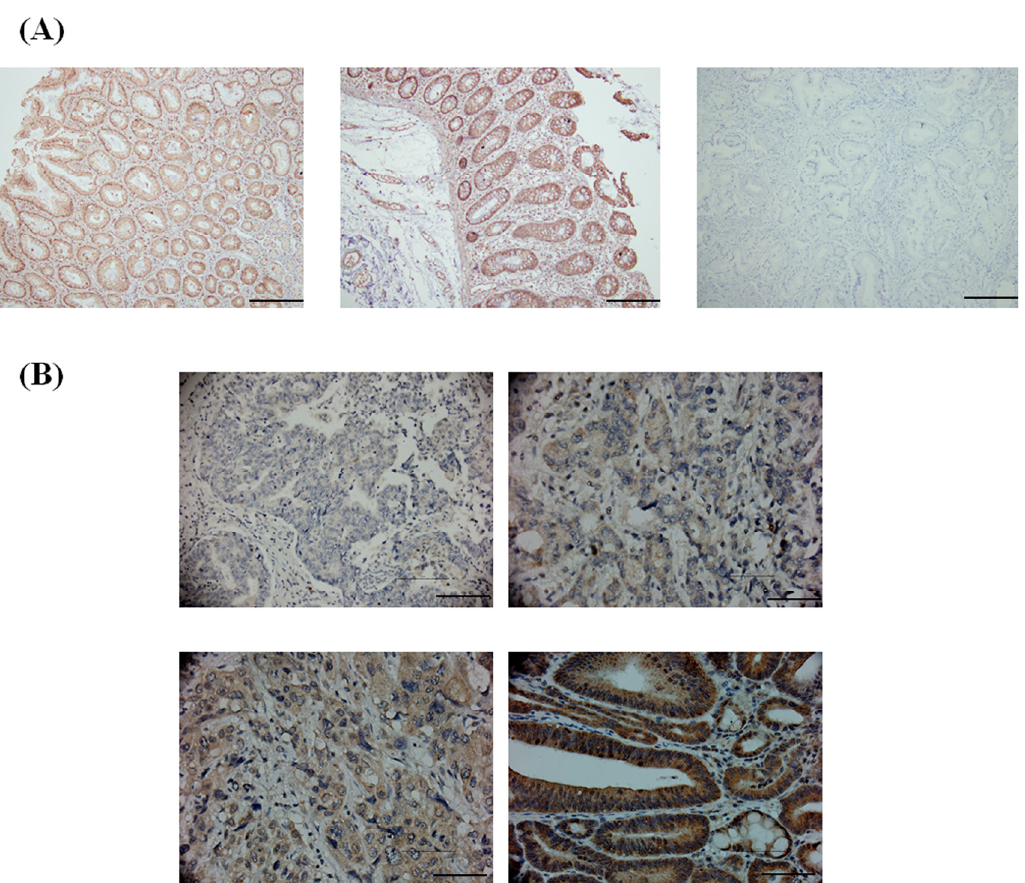
Figure 1. The expression patterns of KLF10 in gastric cancer. ( A ) Representative Immunohisto- chemistry (IHC) images of immunohistochemical staining of KLF10 gastric tissues. Left panel: IHC staining of normal gastric tissue. Middle panel: positive IHC staining region in normal gastric tissues. Right: IHC staining without KLF10 antibody in gastric tissues as negative control. All images magnification × 100. Scale bar: 5 µ M. ( B ) Immunohistochemical staining of KLF10 in gastric cancer. KLF10 was positively detected in the nuclear and cytoplasmic regions. Representative IHC intensity of images of negative (upper panel, left), 1+ (upper panel, right), 2+ (lower panel, left) and 3+ (lower panel, right) were shown. All images magnification × 400. Scale bar: 20 µ M. Table 1. Relationships of KFL10 expression with clinical parameters in 121 gastric cancer patients.